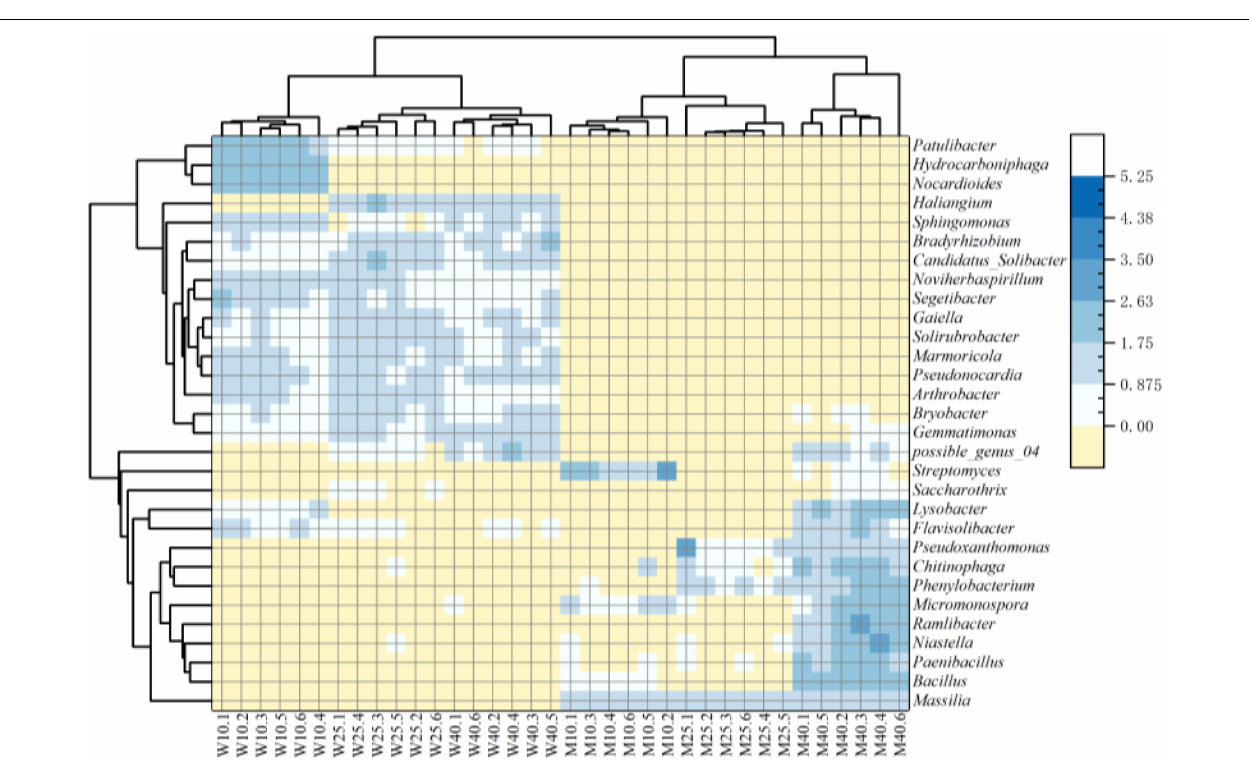
FIGURE 4 | Heatmap of relative abundances of the top 30 genera from the different